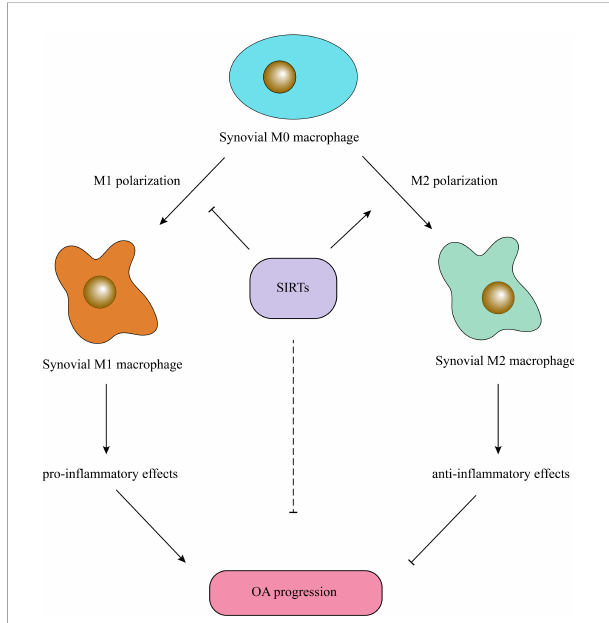
FIGURE 2 SIRTs exert anti-in fl ammatory effects by promoting M2 macrophage polarization. SIRTs inhibit synovial M1 macrophage polarization and promote synovial M2 macrophage polarization, resulting in reduced level of articular in fl ammation and amelioration of